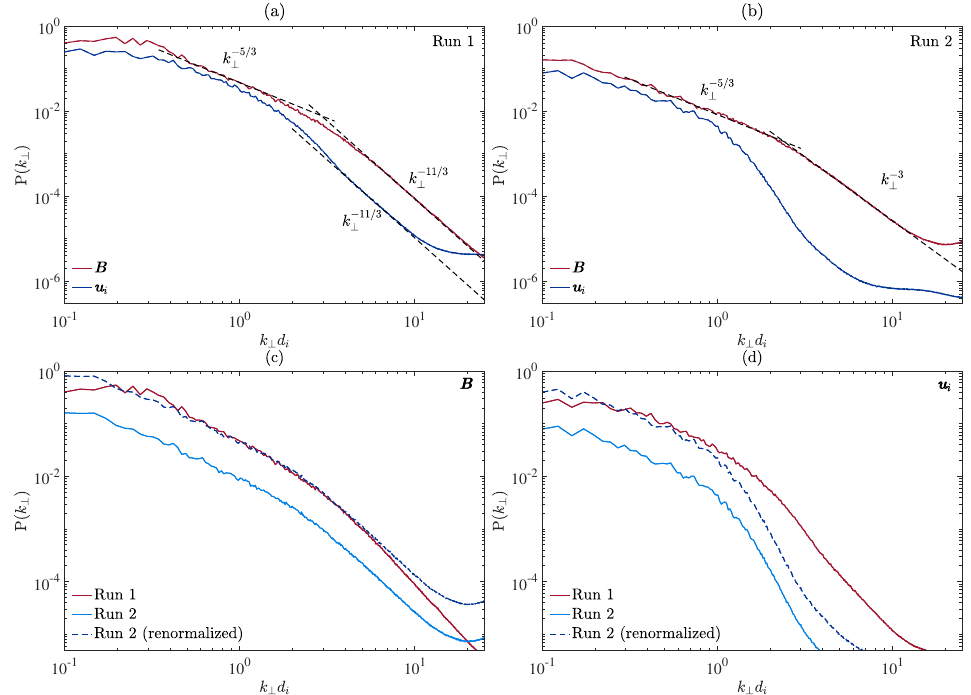
Figure 4. Spectral properties of the magnetic field and ion bulk velocity fluctuations: ( a ) power spectra of B and u i for Run 1 with reference power laws superimposed; ( b ) same as panel ( a ) but for Run 2; ( c ) direct comparison of the magnetic field spectrum of Run 1 and Run 2, with the latter also renormalised by a factor that “corrects” for the lower initial magnetic fluctuations and the slightly larger injection scale (so that the spectra of the two simulations coincide at k ⊥ d i = 1); ( d ) same as panel ( c ) but for the ion bulk